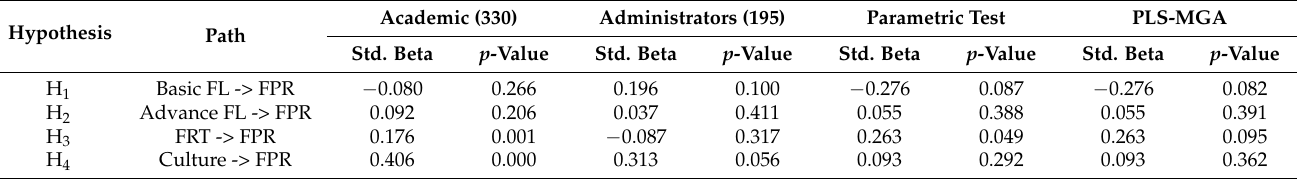
Table 7. Results of